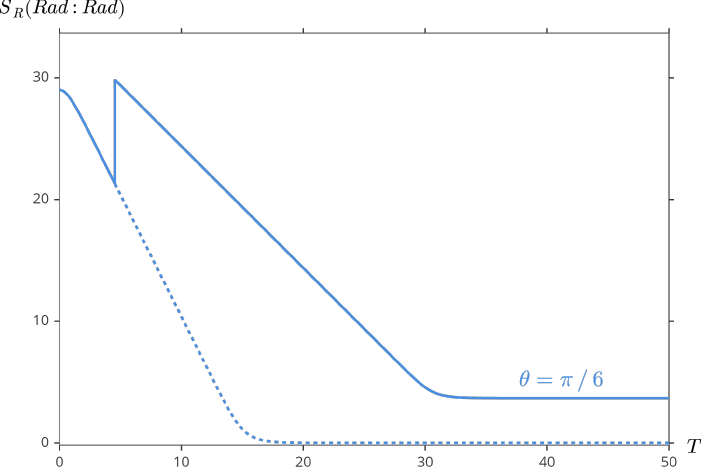
) with respect 3 , (cid:15) y = 0 . 1 , and l = 1 . The solid line represents the 6